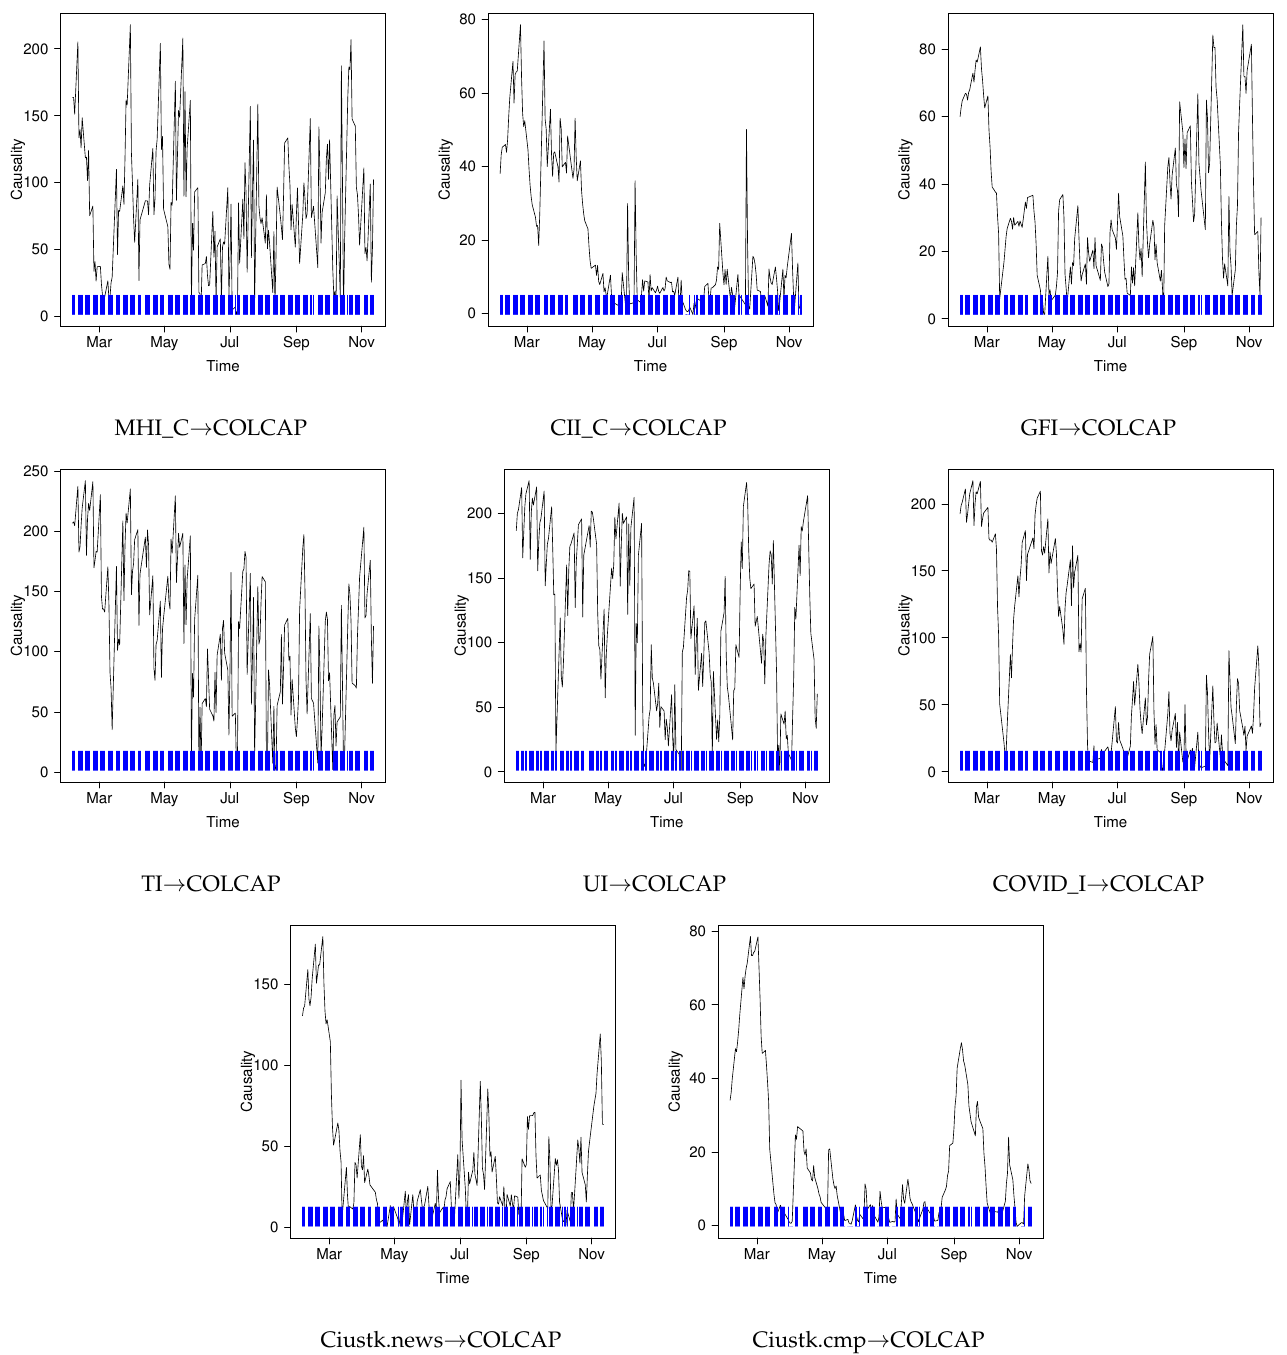
Figure 3. Instantaneous, one-way Granger-causality from news series to COLCAP (DCC- GARCH